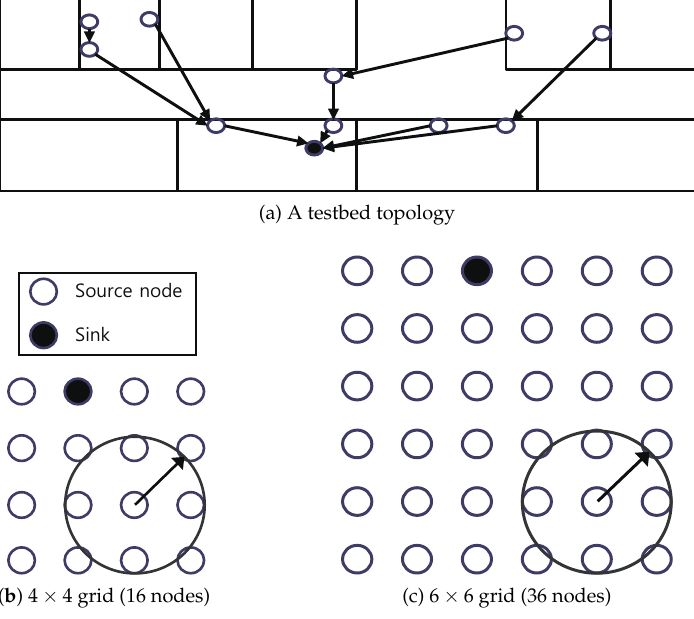
Figure 9. Testbed and simulation